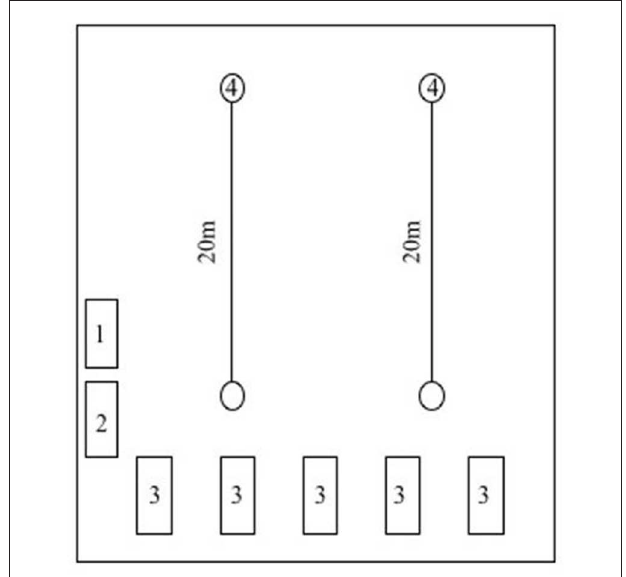
FIGURE 1 | Study setting in school’s gymnasium. Station 1: Measurement of body weight and height. Station 2: Measurement of hand grip strength. Station 3: Measurement of heart rate. blood pressure and pulse wave velocity. Station 4: Shuttle-run